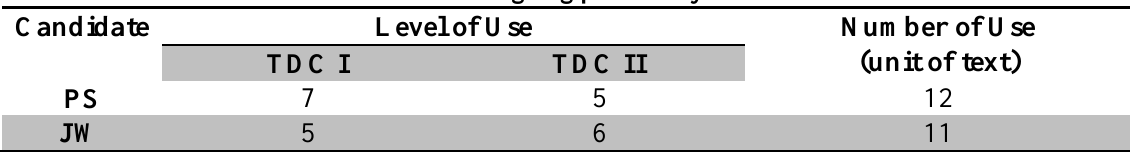
Table 6.15: Level of the use of mixed zig-zag pattern by both Presidential Candidates